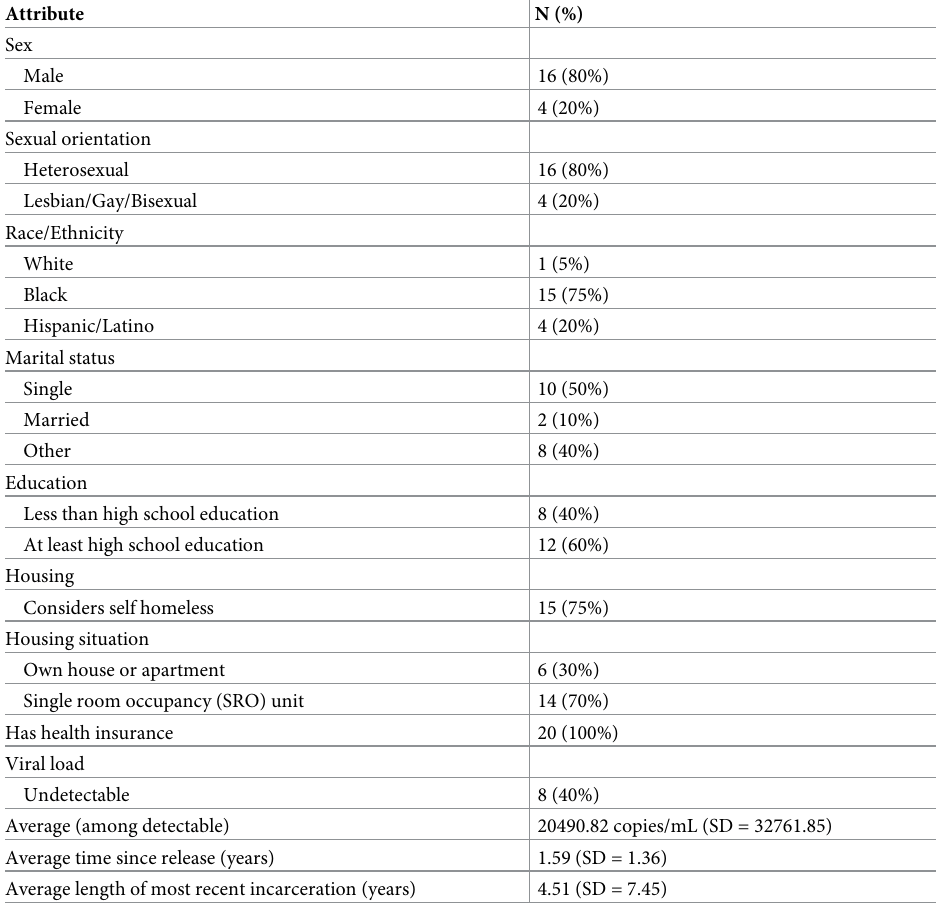
Table 1. Socio-demographic